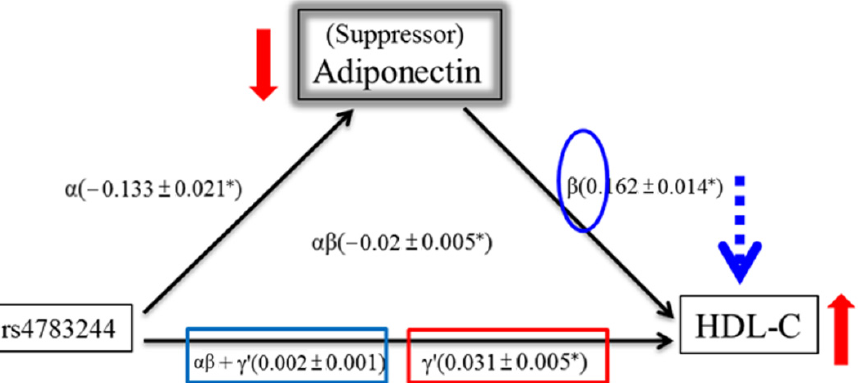
Figure 3. Suppression effect of Adiponectin. A three-variable mediation model: Adiponectin level as a suppressor of association between CDH13 genotype and HDL-C. Linear regression model was used to assess the path associations of α , β , γ ', and αβ + γ